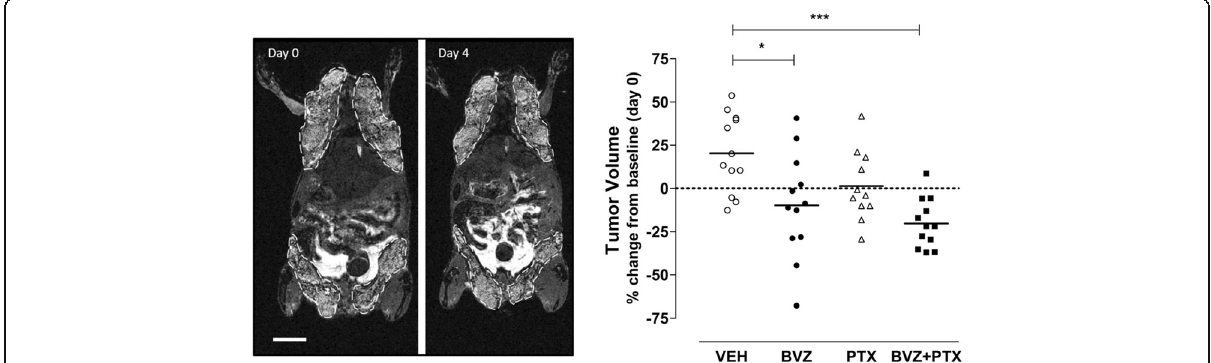
Fig. 2 Therapy response assessments in PyMT mice with MR imaging. a Representative T1-weighted coronal MR images of the PyMT mouse, treated with B20-4.1.1/PTX combination (shown baseline, day 0 and 4 days after the treatment, day 4). Tumor ROIs are outlined with white dashes. Scale bar 10 mm. b Quantification summary of the therapeutic response to treatment ( n = 11 – 12 tumors/group). The comparisons between the groups are shown (Kruskal-Wallis test, * p < 0.05 and *** p < 0.001). The horizontal lines indicate the median values